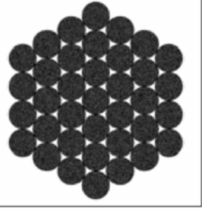
Figure 3. Exit end of the fiber-coupled semiconductor